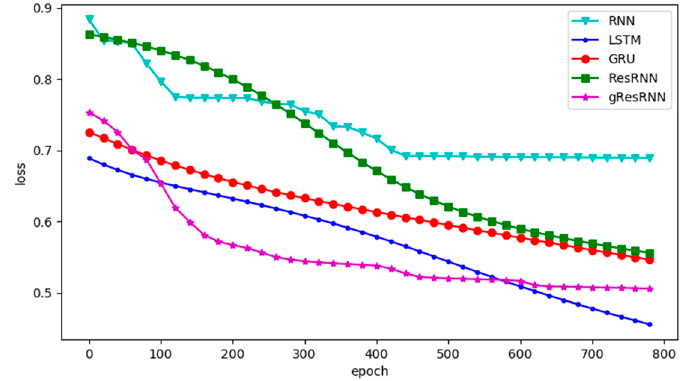
Figure 4. Losses for IMDB database of the RNN [9], LSTM [16] and GRU [17] and Res-RNN, Res-RNN with gates over epochs.